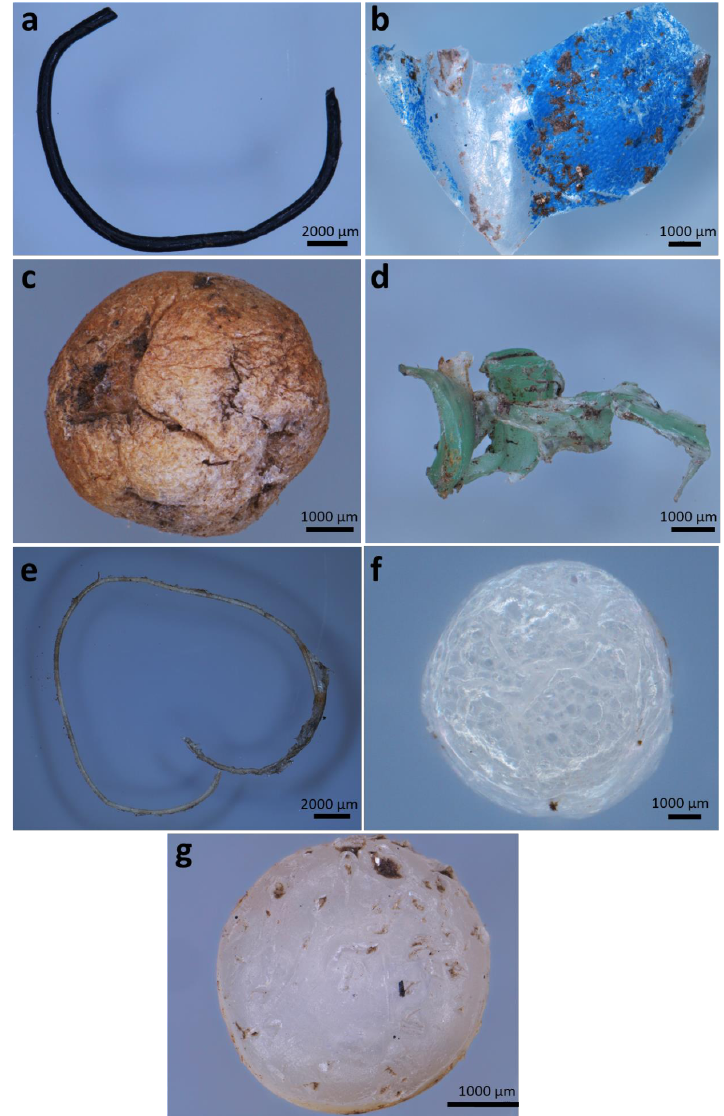
Figure 4. Microplastic morphotypes found within the four estuaries sampled: ( a ) Fibre; ( b ) film; ( c ) foam; ( d ) fragment; ( e ) monofilament line; ( f ) microbead; and ( g ) pellet.